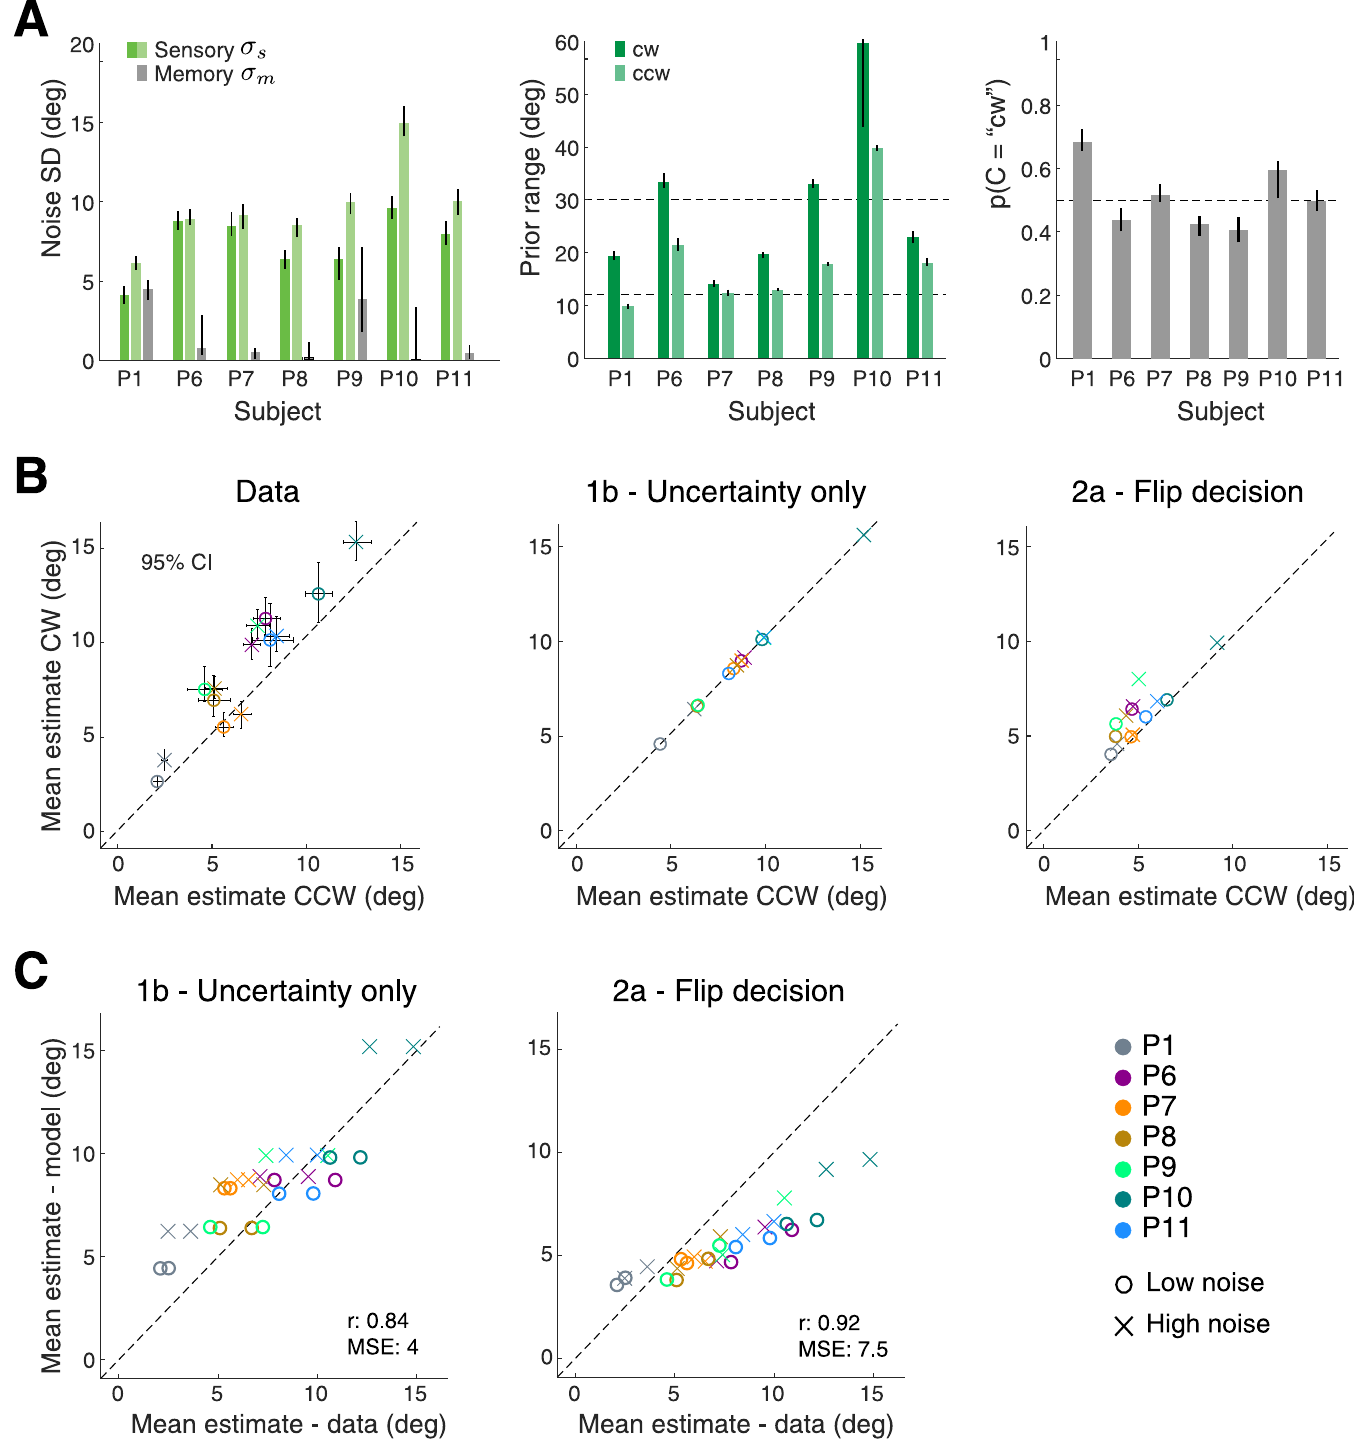
Fig 8. Experiment 2—Fit model parameters and prediction accuracy for individual subjects. (A) Sensory ( σ s ) and memory ( σ m ) noise parameters of individual subjects (correct trials only). The prior width is consistently higher on the cw side for all subjects. In contrast to Exp. 1, the category prior p ( C = “cw”) was a free parameter. On average values are close to the statistically correct value of 0.5. (B) Mean estimates (averaged across stimulus orientations) in incorrect trials are significantly larger on the cw side for all except one subject (P7). Errorbars reflect the 95% bootstrapped sample interval. Model 2a correctly predicts this pattern but Model 1b does not (no prior). (C) Model 1b performs better in terms of MSE between data and model mean estimates but Model 2a’s predictions show a higher correlation. However, the inability to account for the asymmetry in the estimate data is sufficient evidence to rule out Model 1b. Predictions of Model 2a show the same tendency to underestimate estimation magnitudes as in Exp.